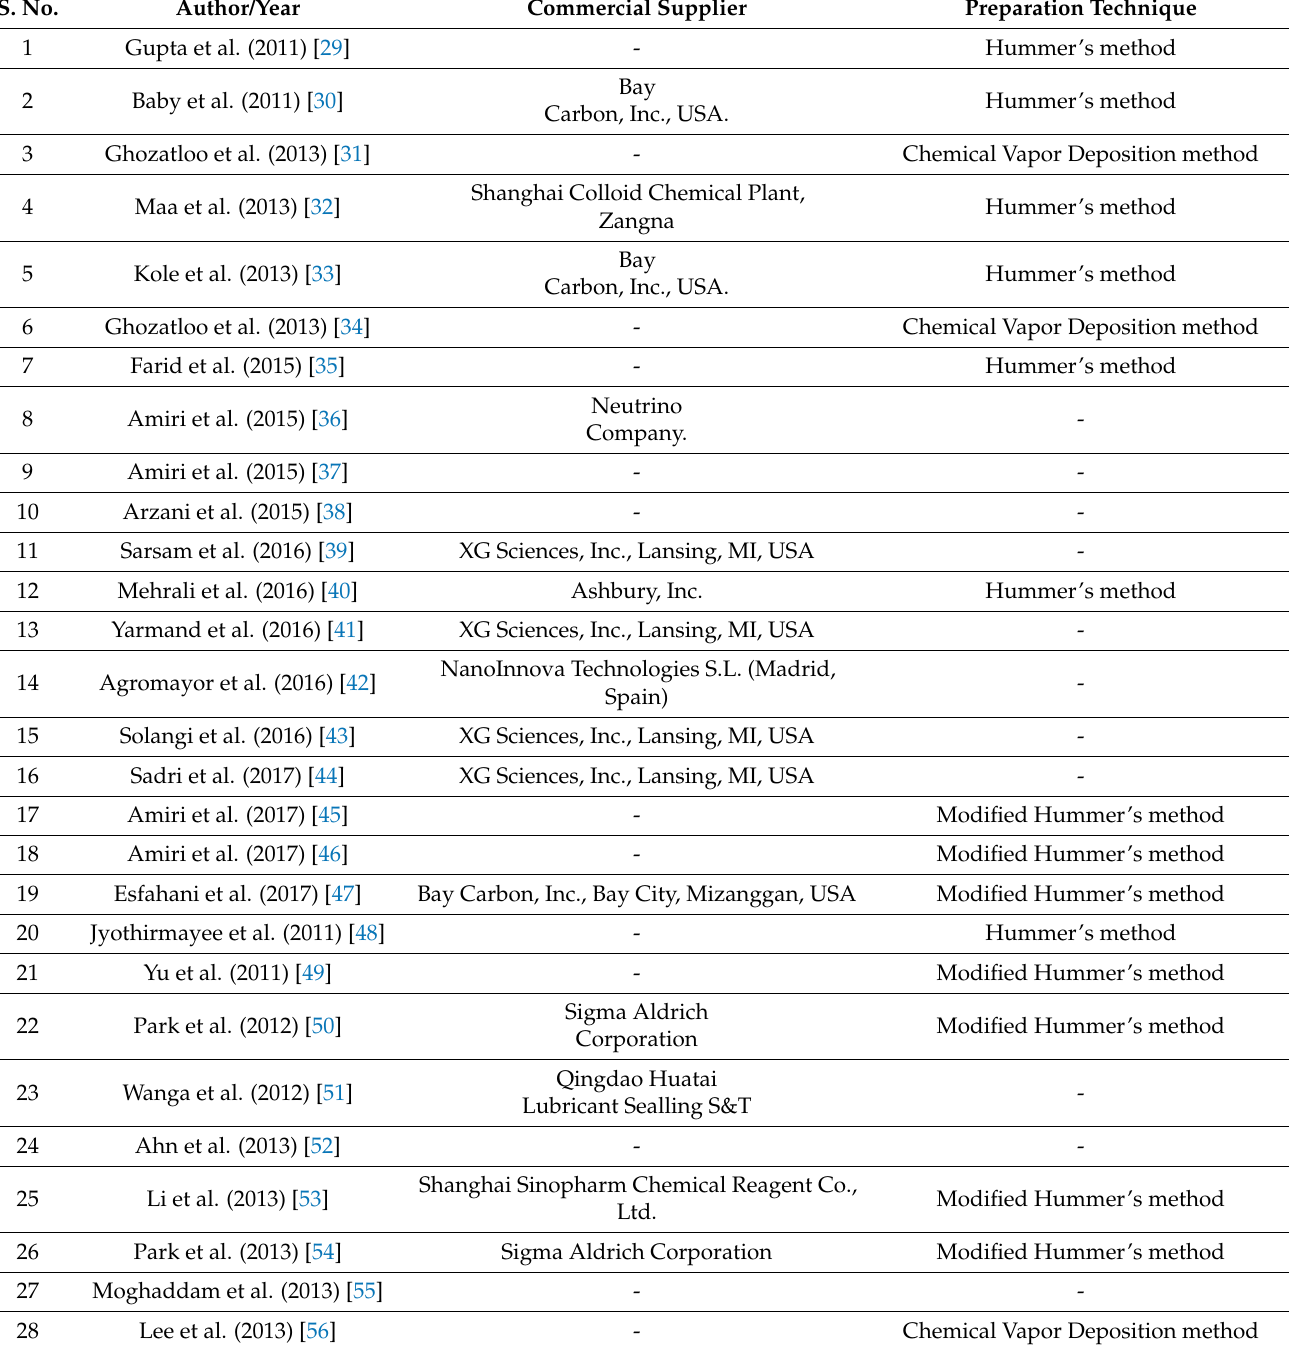
Figure 1. The summary of the published literature on synthesis of graphene powder has been listed in Table 2. Table 2. Summary of published literature on synthesis of